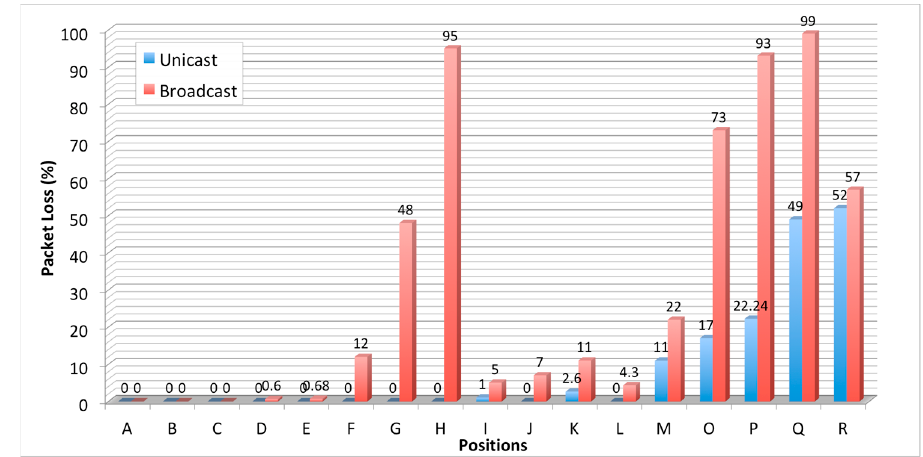
Figure 11. Percentage of packet loss for the various locations of the radio transmitter (shown in Figure 10).